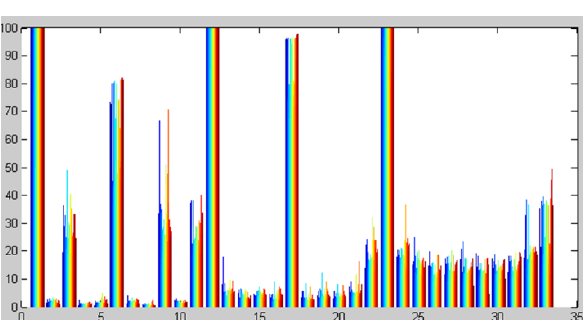
Figure 7. The result of FPFH about road surfaces